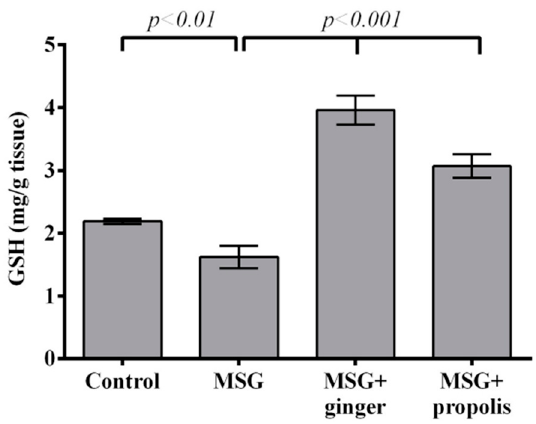
Figure 5. Effects of ginger and propolis aqueous extracts on brain tissue GSH level of the experimental groups. Data are expressed as mean ± SEM ( n = 6). Comparisons were made between normal control and MSG control group, and also between MSG control and MSG plus ginger or propolis supplement groups.